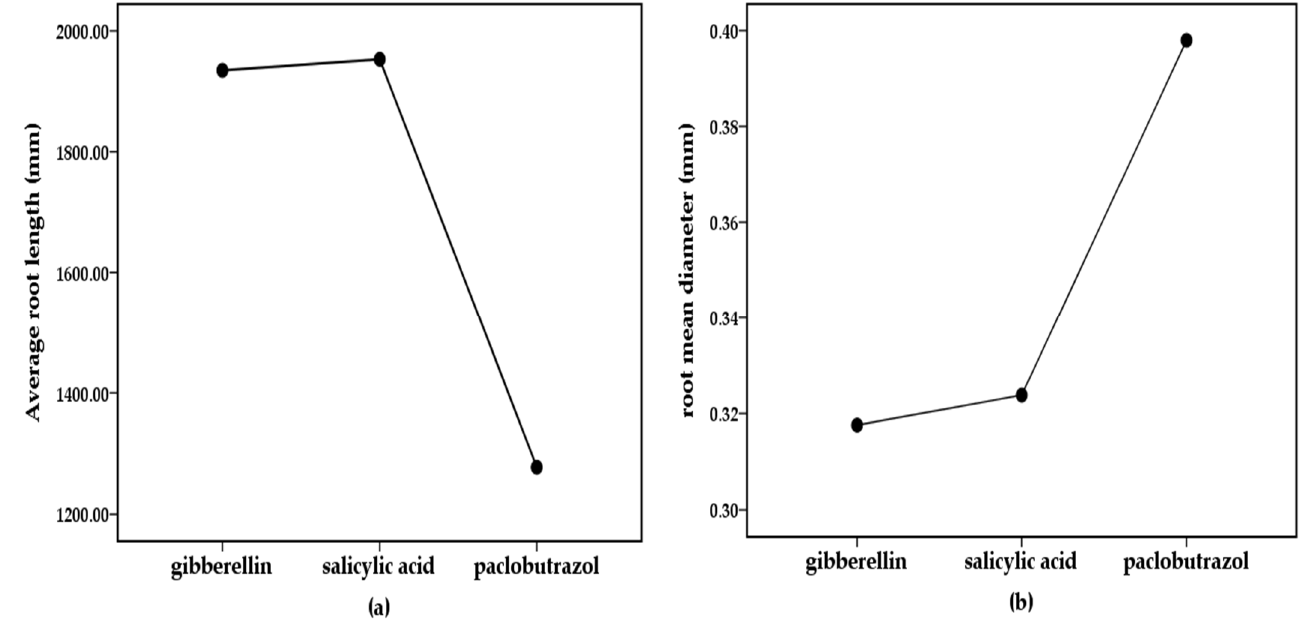
Figure 7. ( a ) Root length with different growth regulators treatments; ( b ) Root mean diameter with different growth regulators treatments.